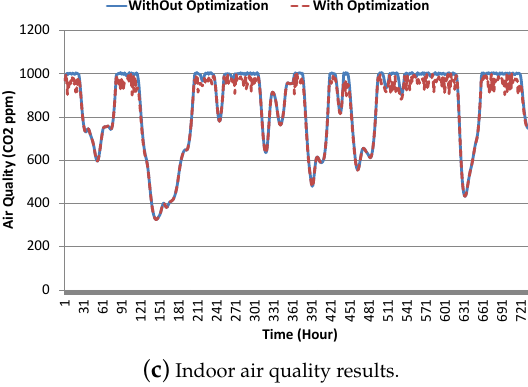
Figure 9. Optimization vs. no-optimization scheme: 31 days (744 h) of